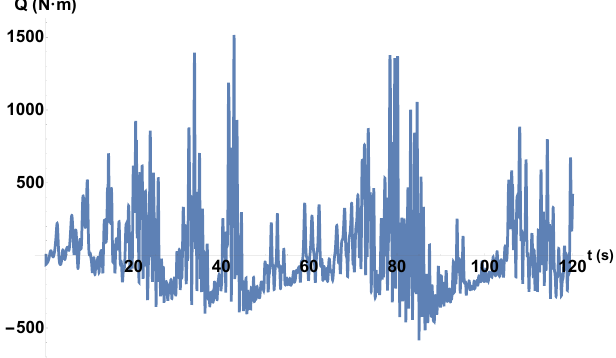
Fig. 12. The torque value fluctuation for symmetric rotor in panchro- matic